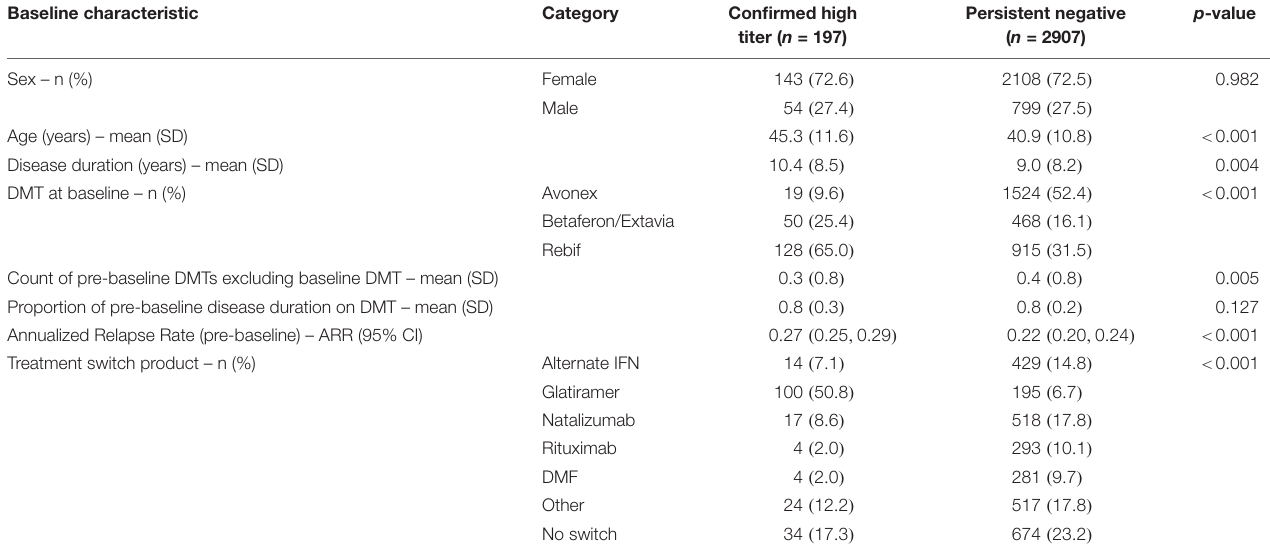
TABLE 1 | Baseline characteristics by NAb titer group.